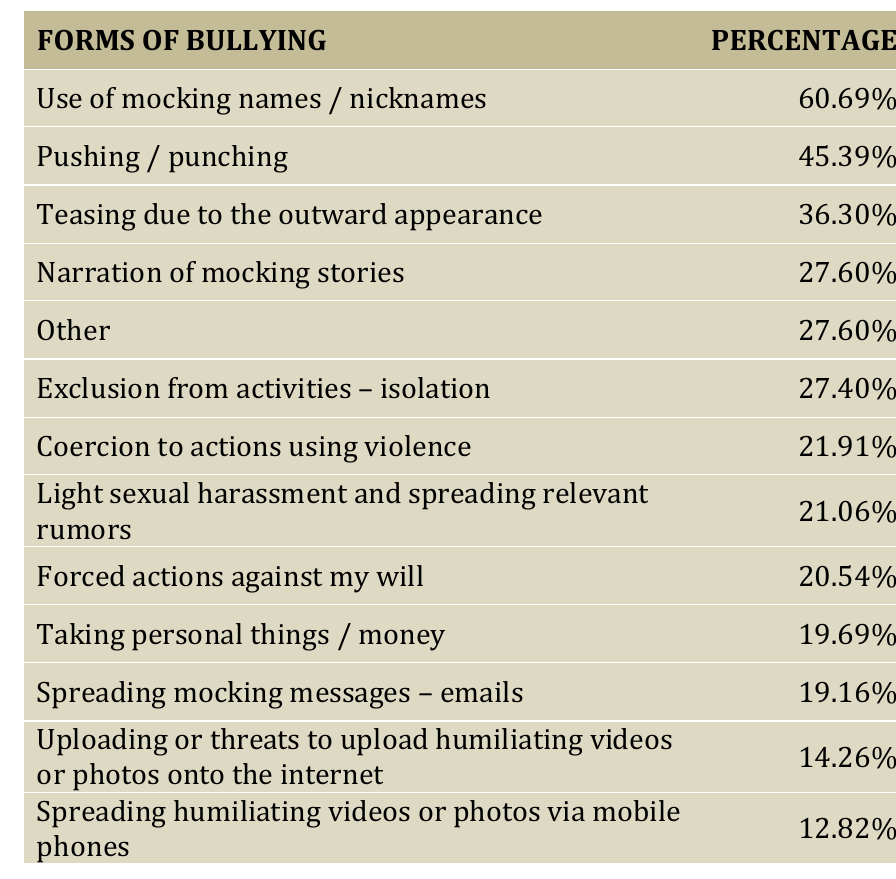
Table I: Forms of School